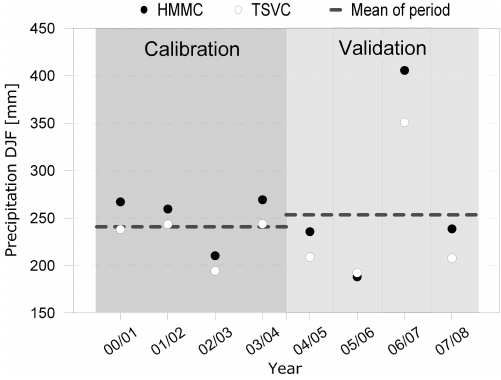
Fig. 4. Winter precipitation (DJF) for calibration and validation pe- riods for the entire